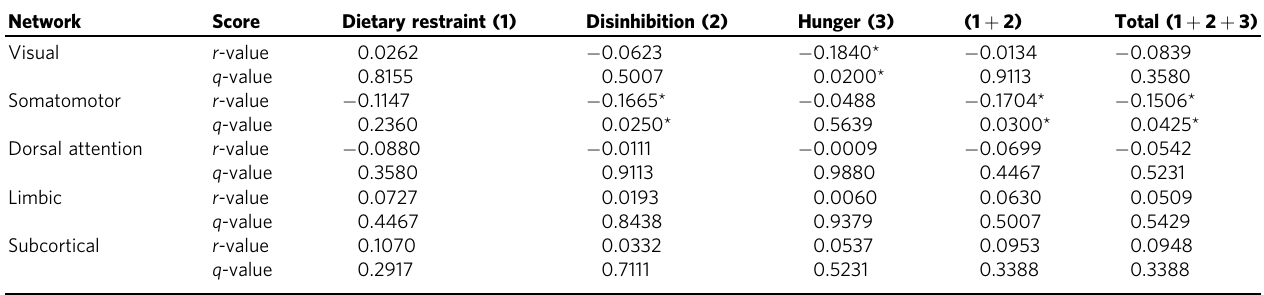
Table 1 Correlations between network-level degree centrality values at step distance fi ve and eating behaviors.